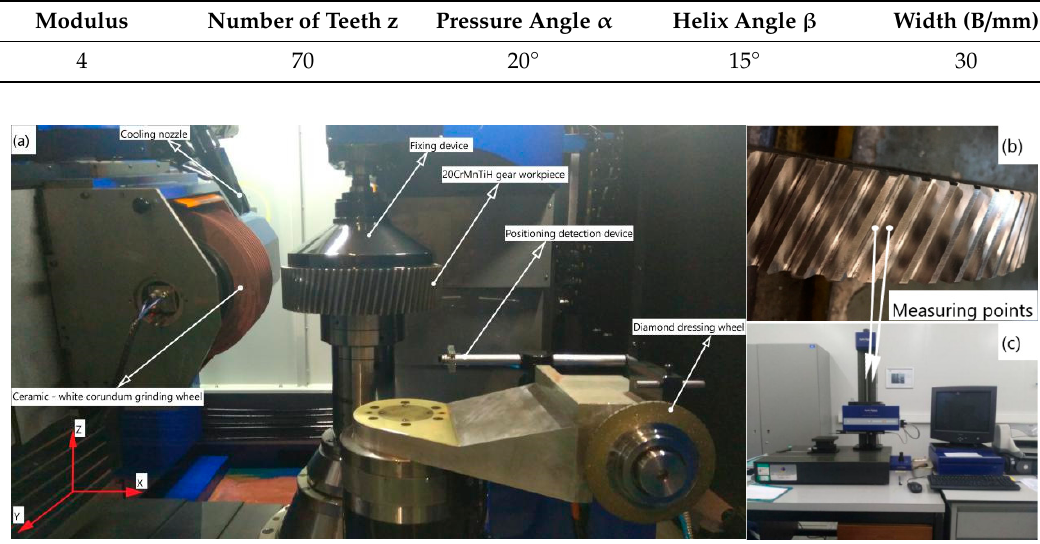
Figure 2. ( a ) Grinding machine; ( b ) Measured points; ( c ) Surface roughness measuring instrument.